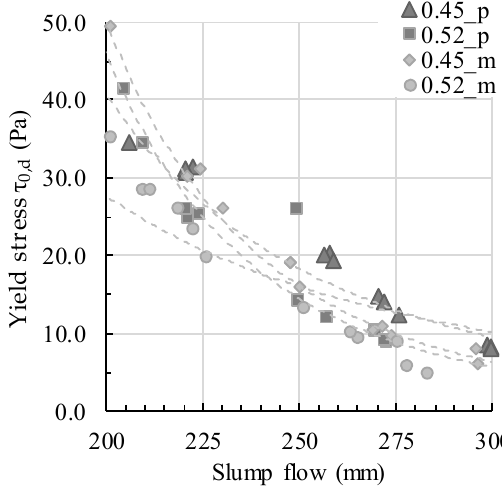
Figure 5. Calculated dynamic yield stress τ 0,d depending on the slump flow value.